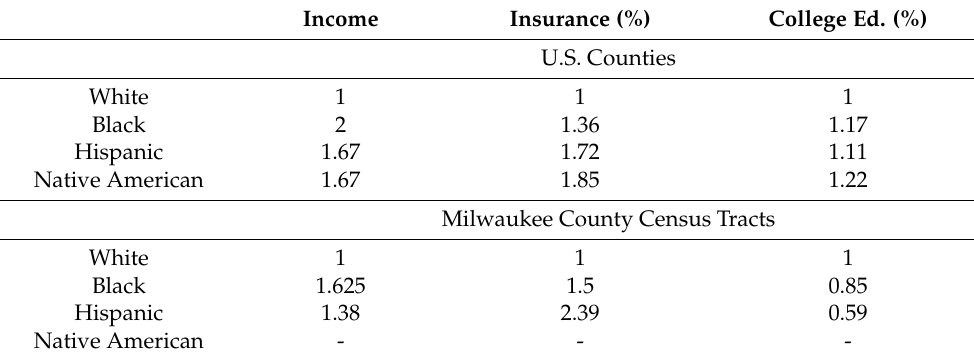
Table 2. Relative magnitude of the median data quality measure (CVs for income, SEs for the others) by ACS variable, geography, and majority racial-ethnic group.